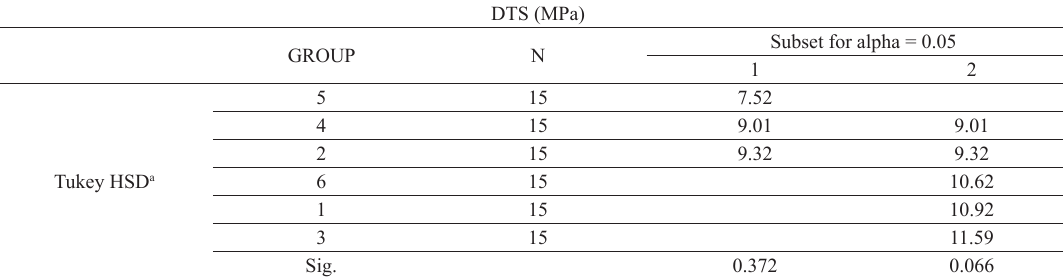
Table 4 - Means of the diametral tensile strength (DTS) of groups in homogeneous subsets.